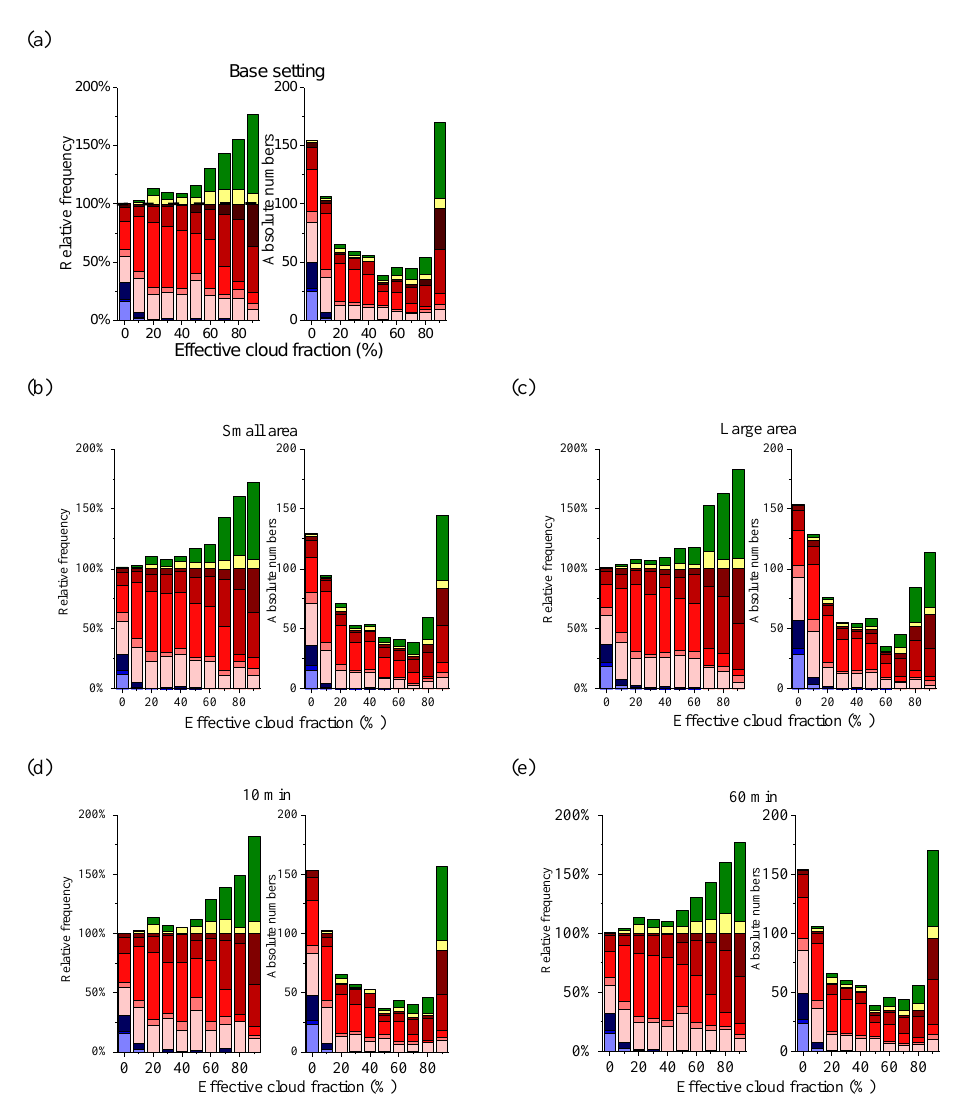
Figure 19. Results of the cloud classification scheme as a function of the effective cloud fraction derived from MODIS (AQUA) for different temporal and spatial averages. (a) Results for the standard settings, spatial averaging of MODIS data: 0.1 ◦ × 0.1 ◦ , temporal averaging of MAX-DOAS data: ± 30min (same as in Fig. 16c); (b) results for spatial averaging of MODIS data: 0.05 ◦ × 0.05 ◦ ; (c) results for spatial averaging of MODIS data: 0.2 ◦ × 0.2 ◦ ; (d) results for temporal averaging of MAX-DOAS data: ± 10min; (e) results for temporal averaging of MAX-DOAS data: ± 60min. Table 3. Average values of various cloud properties derived from the MODIS on Aqua (MYD) and on Terra (MOD) as well as GOME-2 and OMI for clear sky conditions with low or high aerosols (as identified by MAX-DOAS). The missing values mean that the corresponding quantities are not provided by the relevant instrument data set. “Low aerosol” and “high aerosol” in the second row refer to the “clear sky with low aerosol load” and “clear sky with high aerosol load” sky conditions identified by the MAX-DOAS scheme, respectively. MYD MOD OMI GOME2 low high low high low high low high aerosol aerosol aerosol aerosol aerosol aerosol aerosol aerosol Geometrical cloud